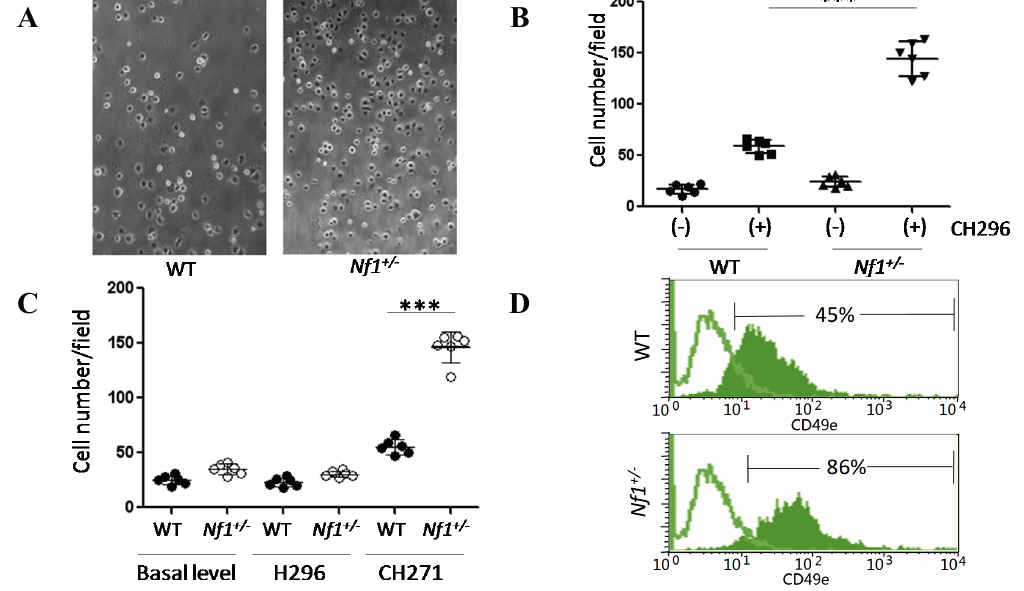
Figure 3. Enhancement of cellular adhesion in Nf1 +/ − MSPCs. ( A ) MSPCs were